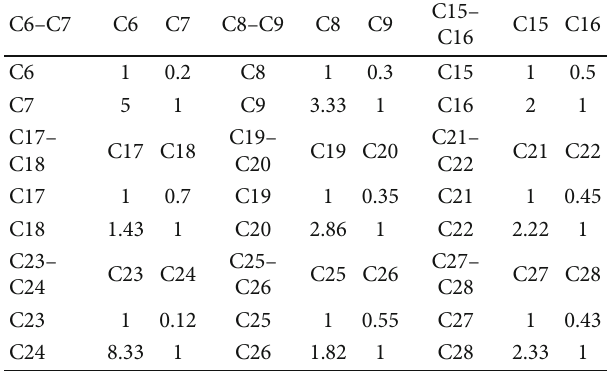
Table 9: Survey results for third-layer attribute membership. Attribute Very good Good